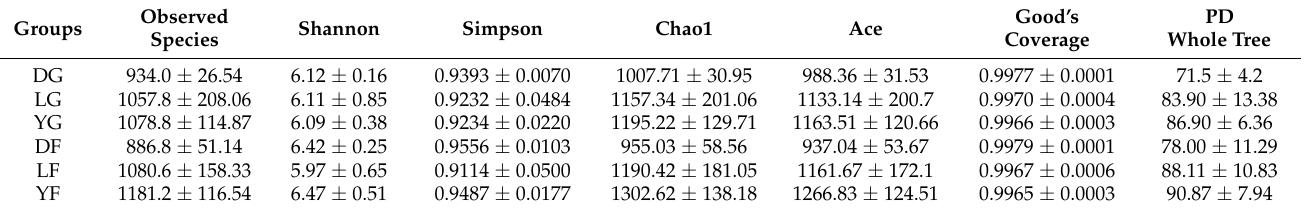
Table 5. Alpha diversity of gut microbiome in pigs in early and late growth